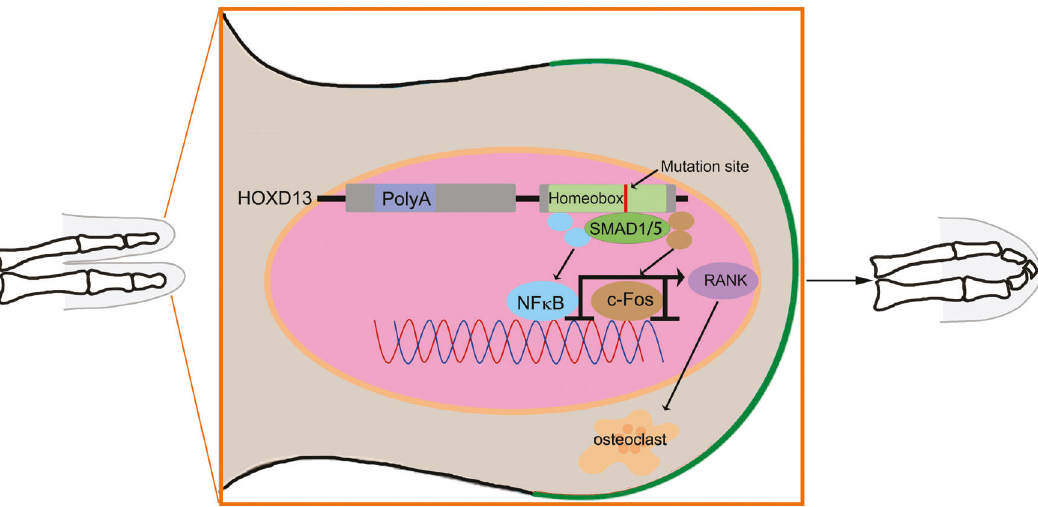
Fig. 7 The Hoxd13 mutation promoted osteoclast differentiation by regulating pSmad5/p65/c-Fos/Rank axis. Schematic diagram described the possible functional mechanism of the Hoxd13 mutation in the osteoclast